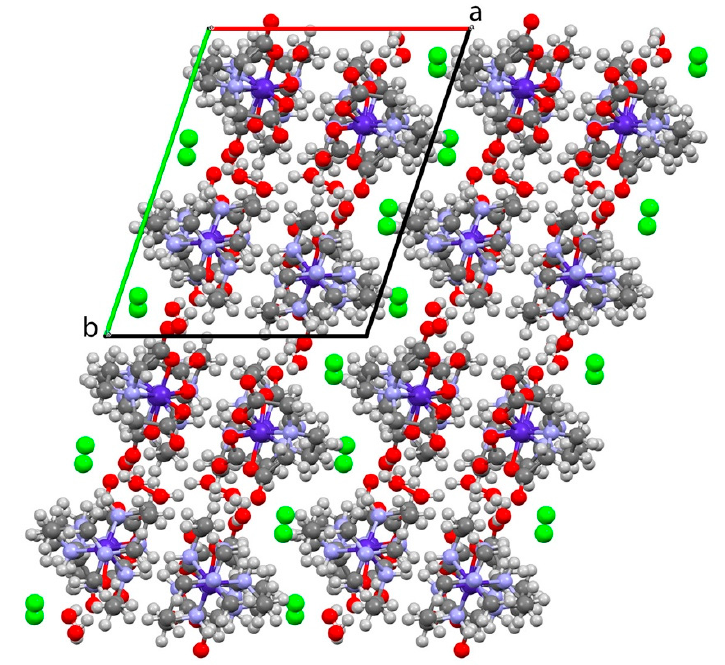
Figure 4. Packing diagram for [Co(sep)][Co(edta)]Cl 2 · 2H 2 O looking down the crystallographic c-axis. Note the hydrophobic channels parallel to the b/c plane alternating with the hydrogen-bonded channels containing the Cl − ions.